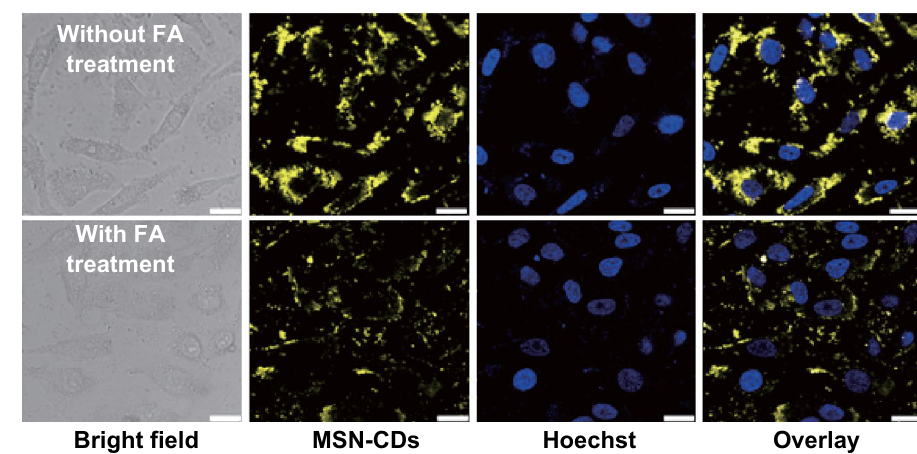
Fig. 5 CLSM images of HeLa cells incubated with MSNs–CDs (200 μg mL −1 ) for 4 h. As a comparison, HeLa cells were pretreated for 2 h with excess folic acid (FA) for folate receptor (FR) saturation and then incubated with MSNs–CDs (200 μg mL −1 ) for another 4 h. Scale bar is